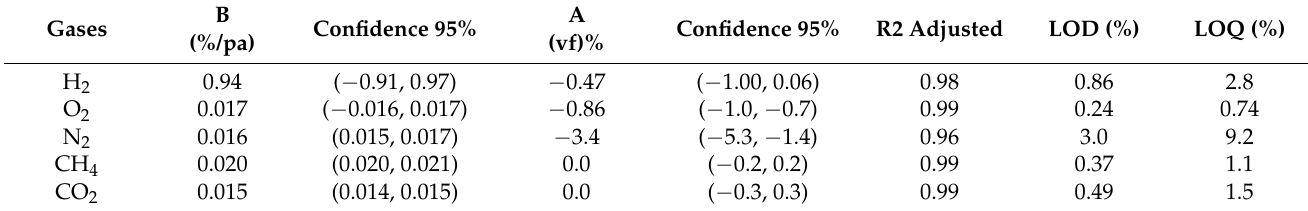
Table 3. Linear regression parameters for every gas. The table includes estimated values with a 95% interval of confidence. It also shows the R2 of the regression and the limit of detection and limit of quantification for each